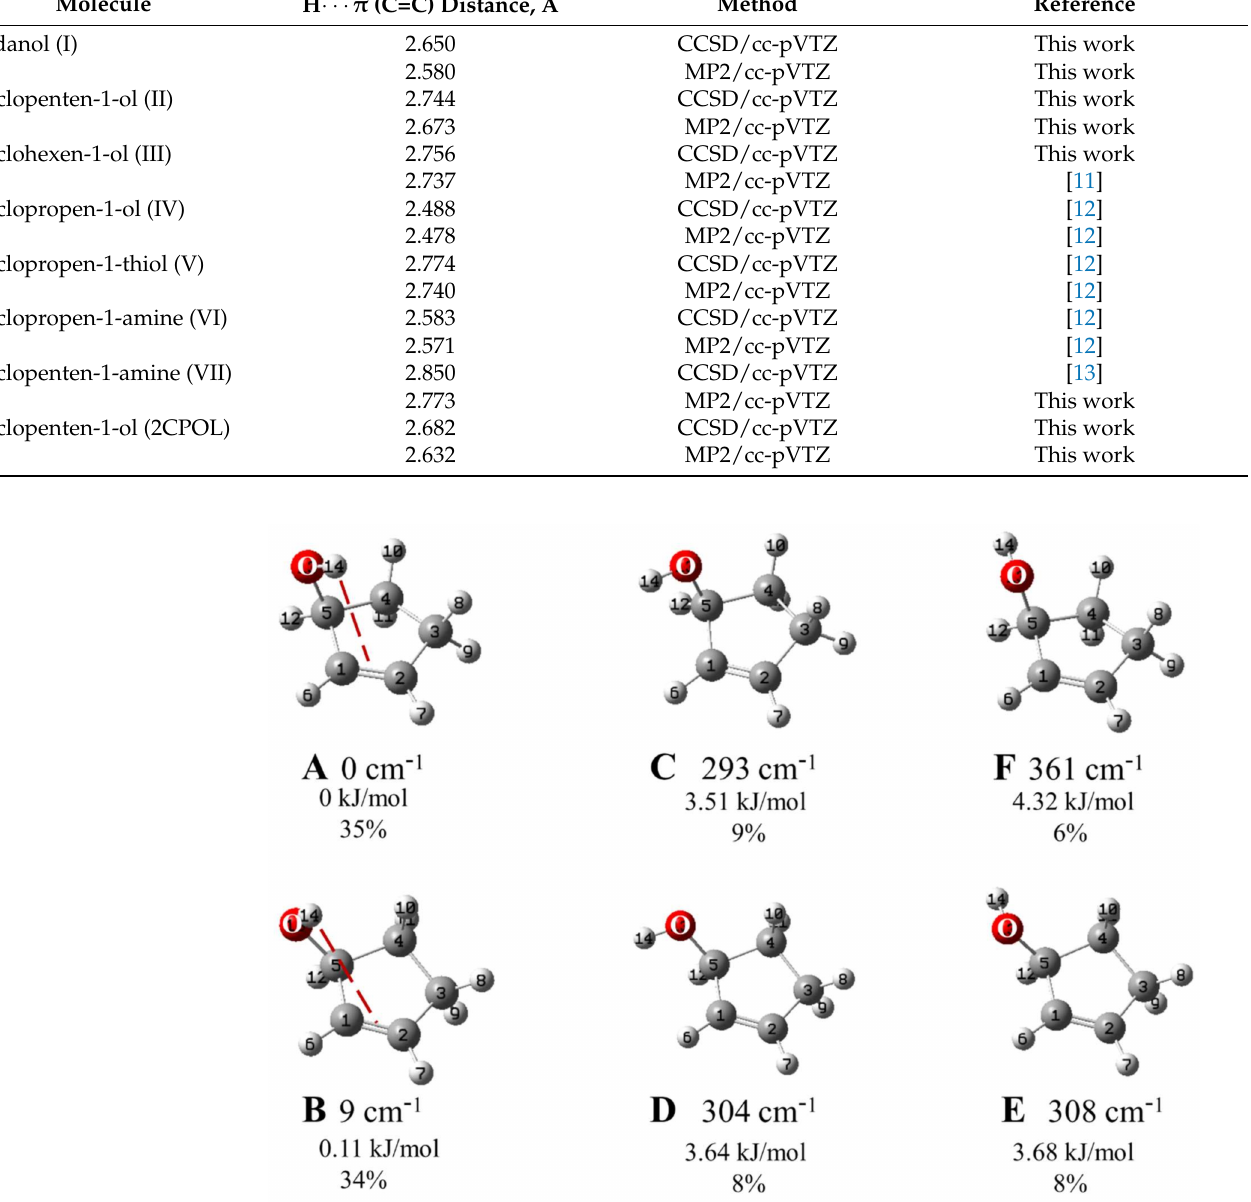
Figure 2. Calculated conformational minima, relative energies, and calculated abundances at 25 ◦ C of 2CPOL from CCSD/cc-pVTZ computations. Conformers A, C, and F are puckered down, whereas conformers B, D, and E are puckered